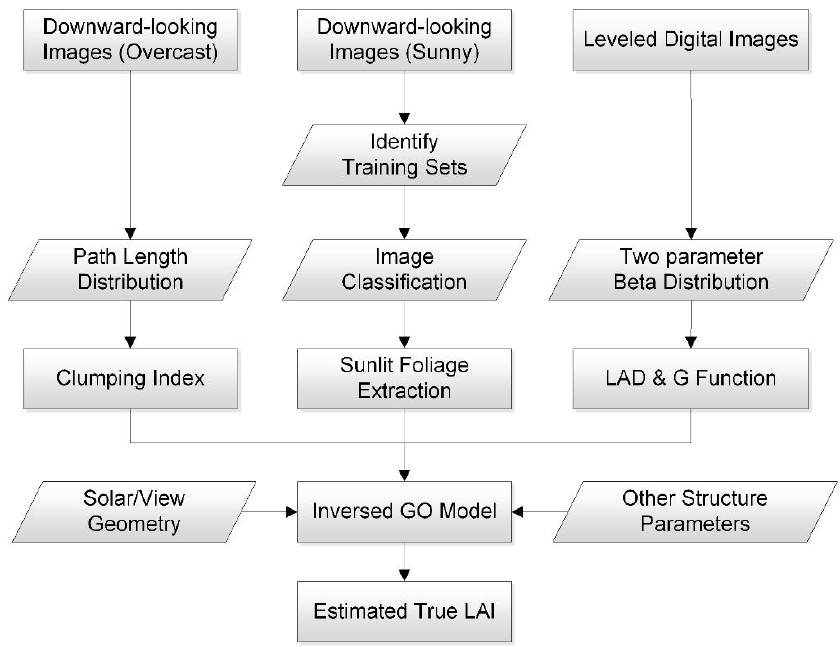
Figure 1. The flow chart of procedures to extract LAI from downward-looking digital photography under clear-sky